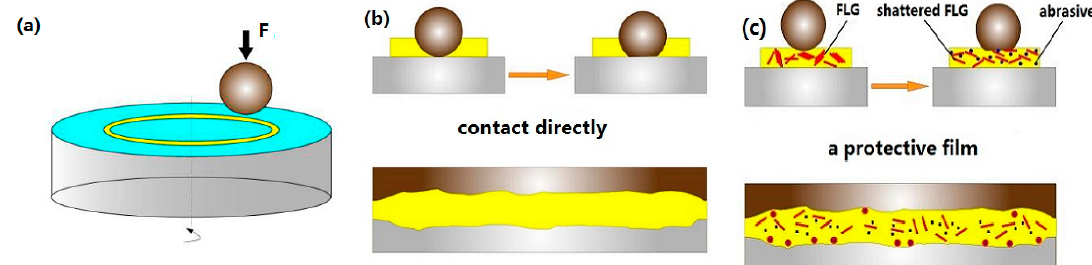
Figure 7. Schematic mechanism for FLG in Mdol. ( a ) Schematic diagram of the friction experiment, ( b ) lubrication diagram of pure lubricating oil, and ( c ) lubrication diagram of FLG suspended in base oil.